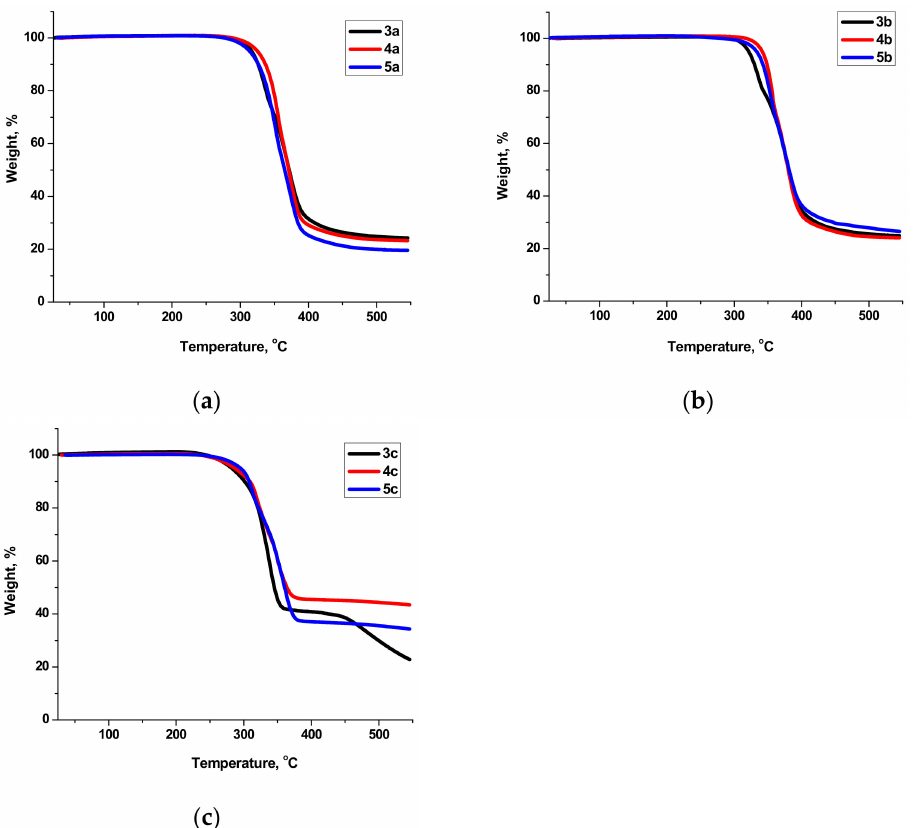
Figure 3. The thermogravimetric (TG) curves for the europium(III) ( a ), samarium(III) ( b ) and terbium(III) complexes ( c